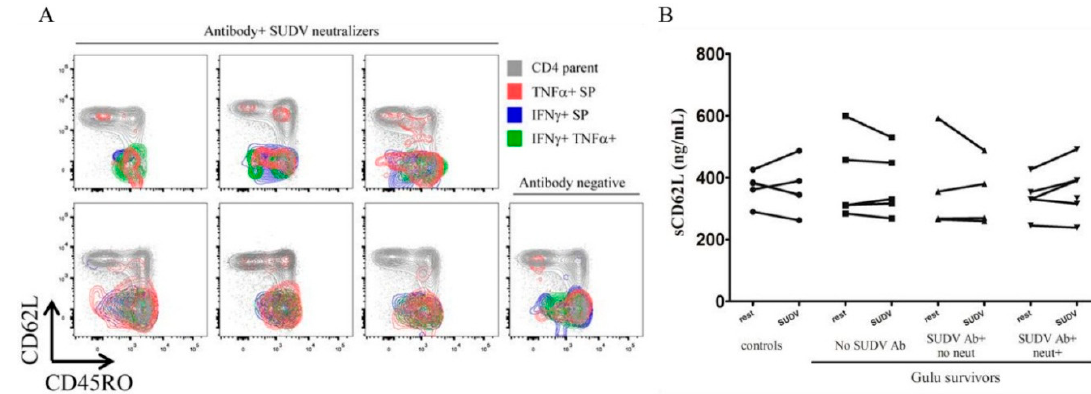
Figure 3. Memory subset analysis of CD4 T cell cytokine responses from survivors and non-infected controls following SUDV whole antigen stimulation. Subsets of CD4 T cell cytokine responses